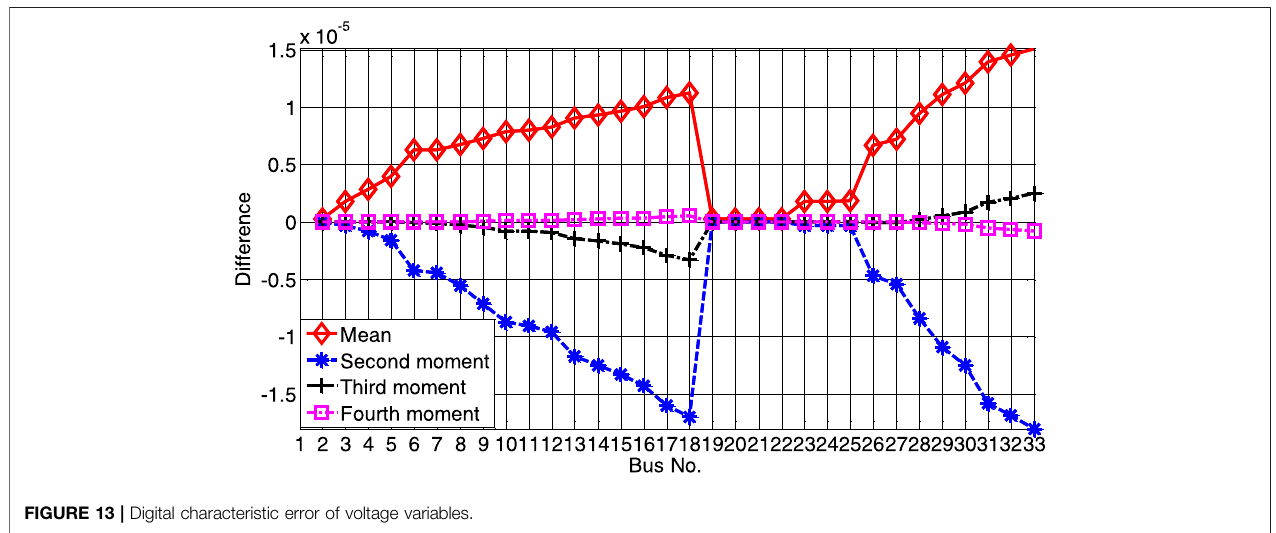
FIGURE 13 | Digital characteristic error of voltage variables.